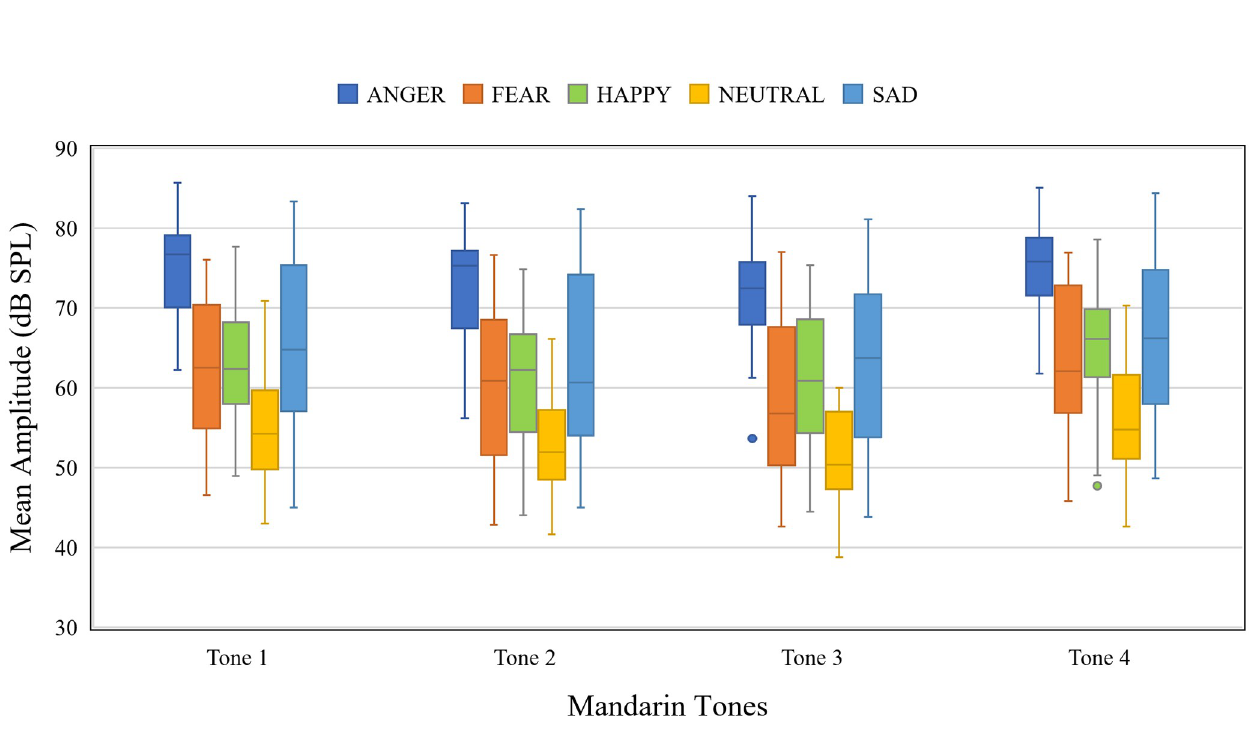
Fig 4. Boxplot showing the mean amplitude of target syllables as a function of Mandarin tone and emotion.